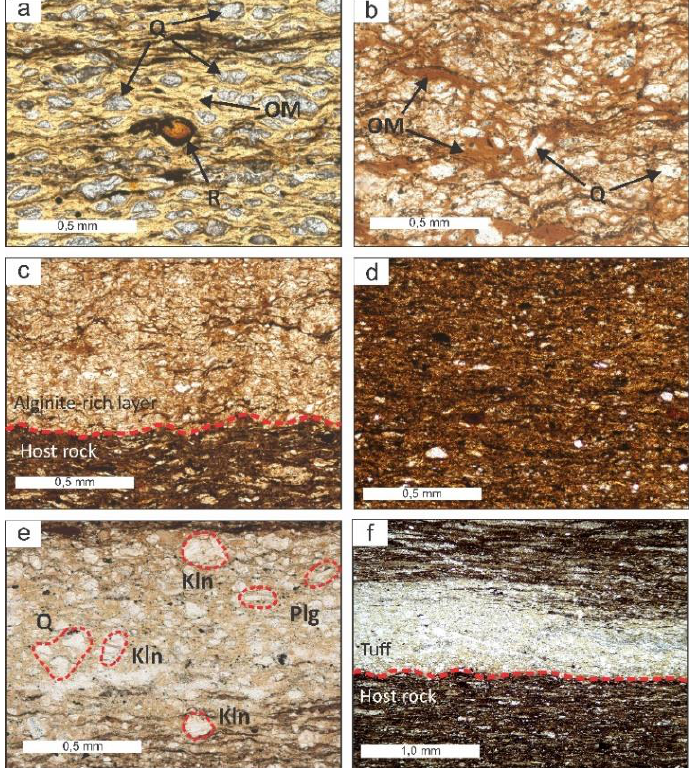
Figure 4. Typical thin section photomicrographs of the alginite-rich layers, host rocks, and tuffs. ( a,b ) Alginite-rich layers, predominantly containing organic matter (OM) and aggregates of quartz (Q), radiolarians (R) are rare; ( c ) alginite-rich layer and host rock that are separated by wavy surfaces (highlighted by red short-dashed line); ( d ) host rock shows the distribution of mineral matrix with organic matter along beddings; ( e ) tuff shows former glassy ash matrix devitrified to crystals of plagioclase (Plg), quartz (Q), kaolinite (Kln), and clay matrix; ( f ) host rock contains thin tuff layer. All photomicrographs are taken under parallel nicols. Corresponding magnification of ( a – e ) 20× and ( f ) 10×.